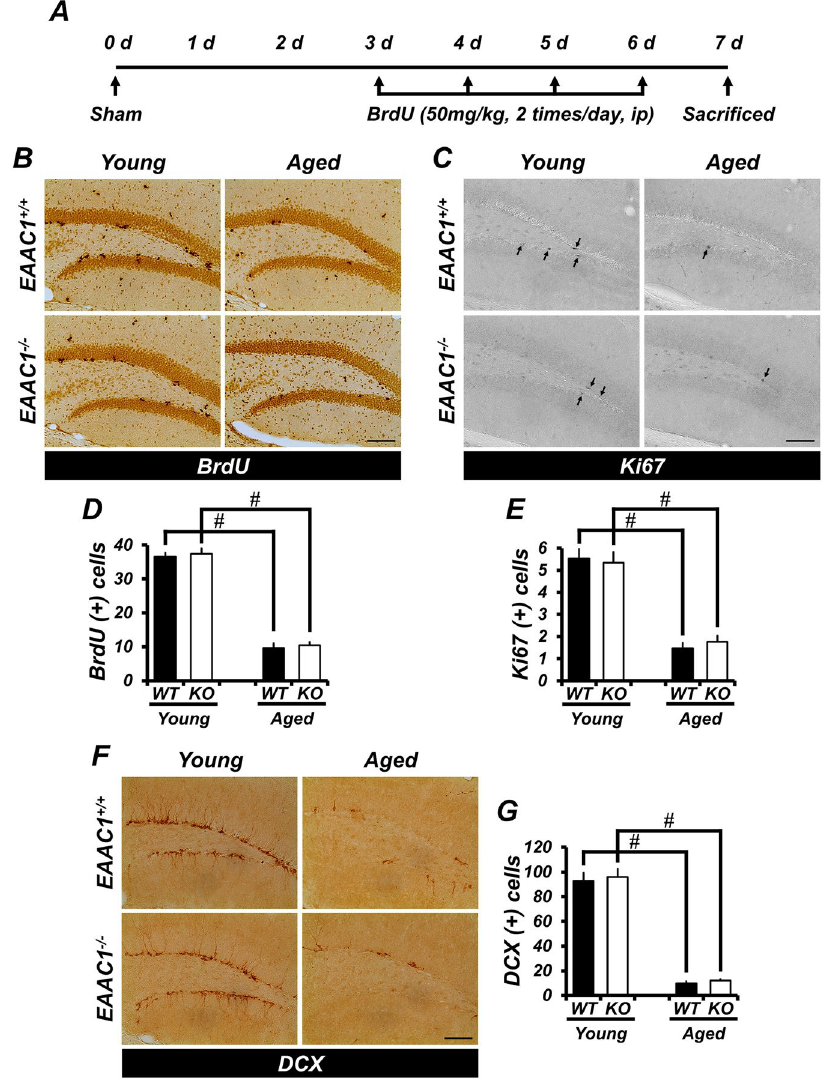
Figure 4. Progenitor cell proliferation and neuroblast production are not different between WT and EAAC1 − / − mice. ( A ) The schematic diagram shows the experimental procedure used in this study. BrdU was intraperitoneally injected twice per day for 4 consecutive days from day 3 after sham surgery. Mice were killed on day 7. ( B , C , F ) Representative images reveal BrdU- ( B ) Ki67- ( C ) and DCX-labeled cells ( F ) in the hippocampal DG of young and aged mice (WT or EAAC1 − / − ) at 7 days after sham surgery. The Ki67-expressing cells are indicated by an arrow. Scale bar = 100 μ m. (D,E,G) The bar graph shows the number of BrdU- ( D ) Ki67- ( E ), and DCX-labeled cells ( G ) in the SGZ from young and aged mice (WT or EAAC1 − / − ) at 7 days after sham surgery. Data are expressed as the mean + SEM; n = 6–10 from each group, # p < 0.05 versus young